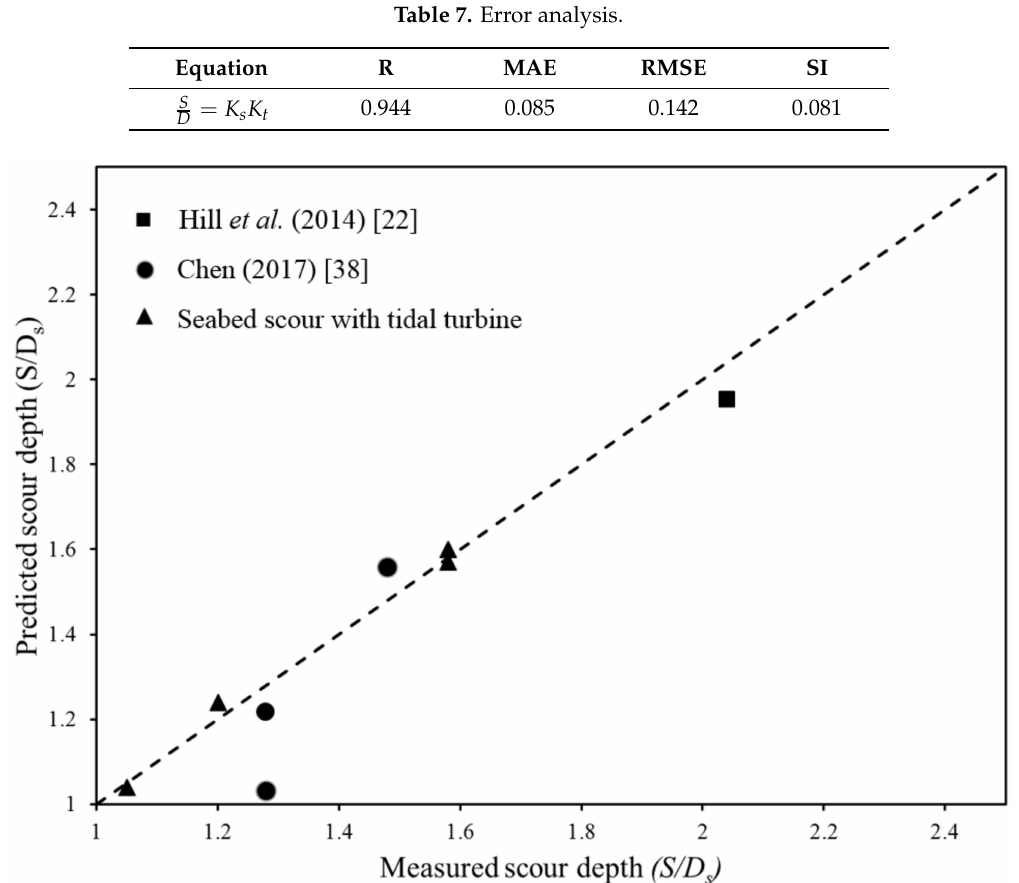
Table 7. Error analysis.